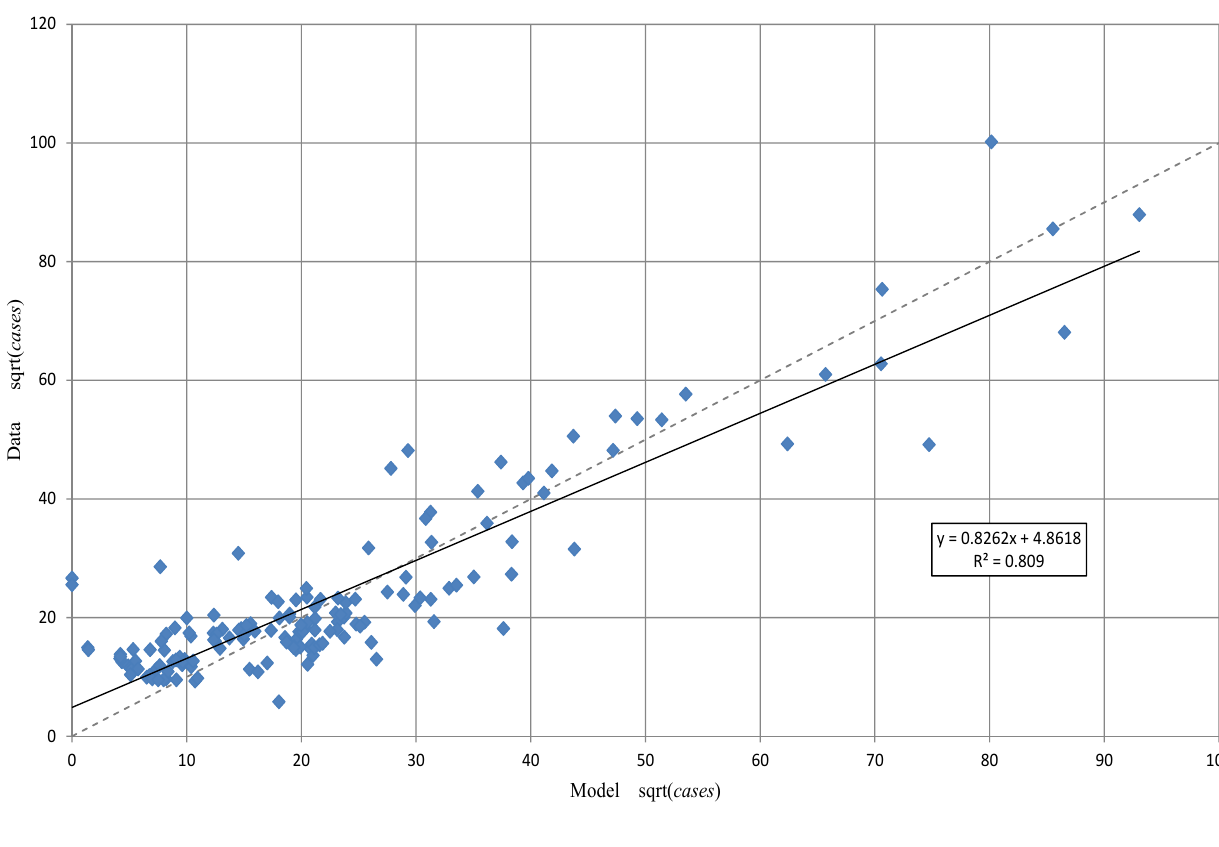
Figure 6. Artibonite. The predicted new symptomatic individuals, against weekly reported cases to 1 April 2012 (square root transformed). A regression line matching the main diagonal (45 ◦ ) dashed line would show an optimal fit; the discrepancy is due in part to fitting on the cumulative